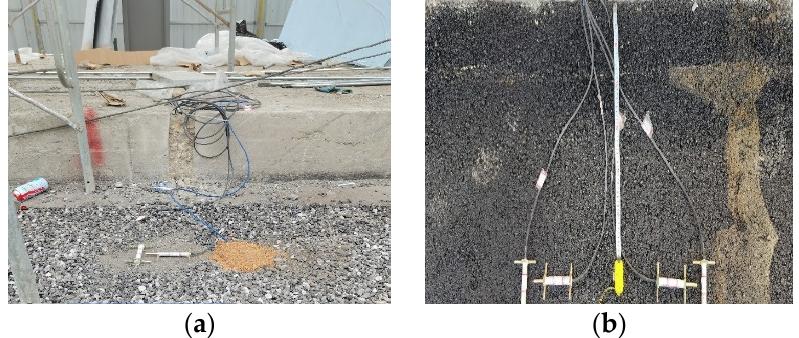
Figure 3. Stress and strain gages in the test section. ( a ) The bottom of the AC layer. ( b ) The bottom of the SFP layer.